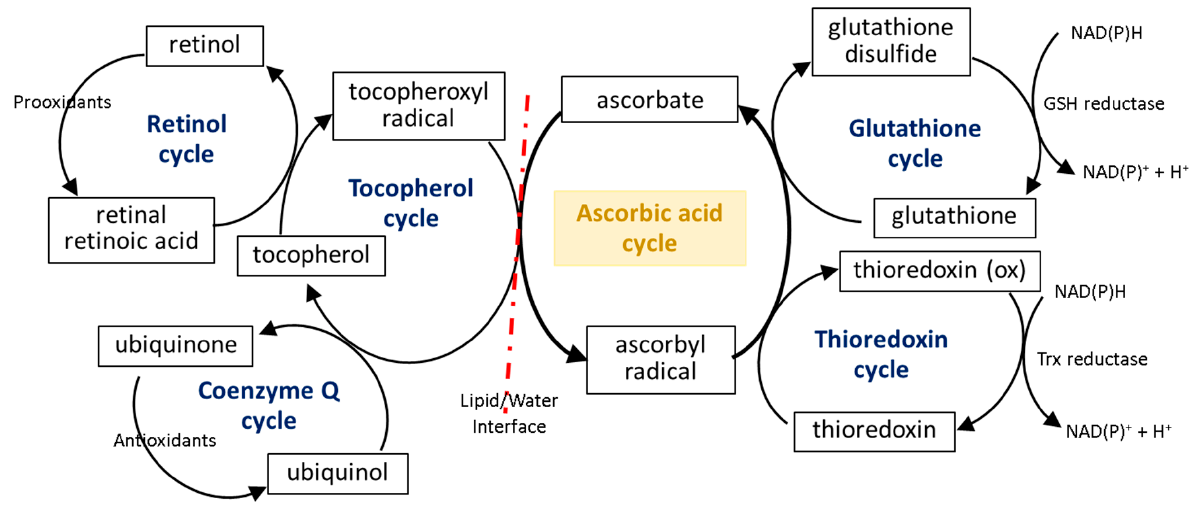
Figure 4. Scheme of the interaction of ascorbic acid with glutathione (GSH), thioredoxin (Trx), coenzyme Q, α -tocopherol, and retinol [49–51,53].